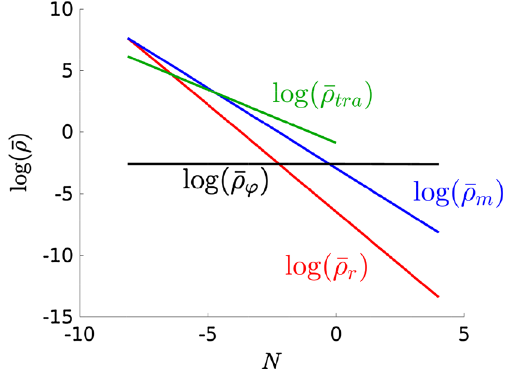
Fig. 2 Qualitative evolutions of different energy densities have been presented for α = 4, rehating temperature T rh = 100 TeV and M = 18 . 1 GeV. The blue, red, green and black curves respectively present the matter, radiation, tracker solution and the scalar field where all of them are considered in the logarithmic units. The initial conditions for all the curves are taken at the matter-radiation equality